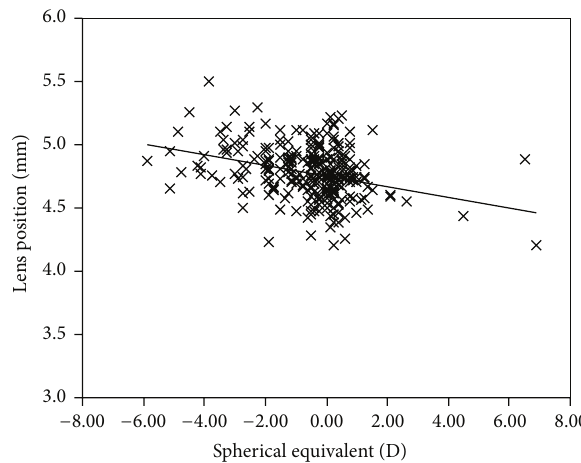
Figure 2: Association between lens position and refractive status in the